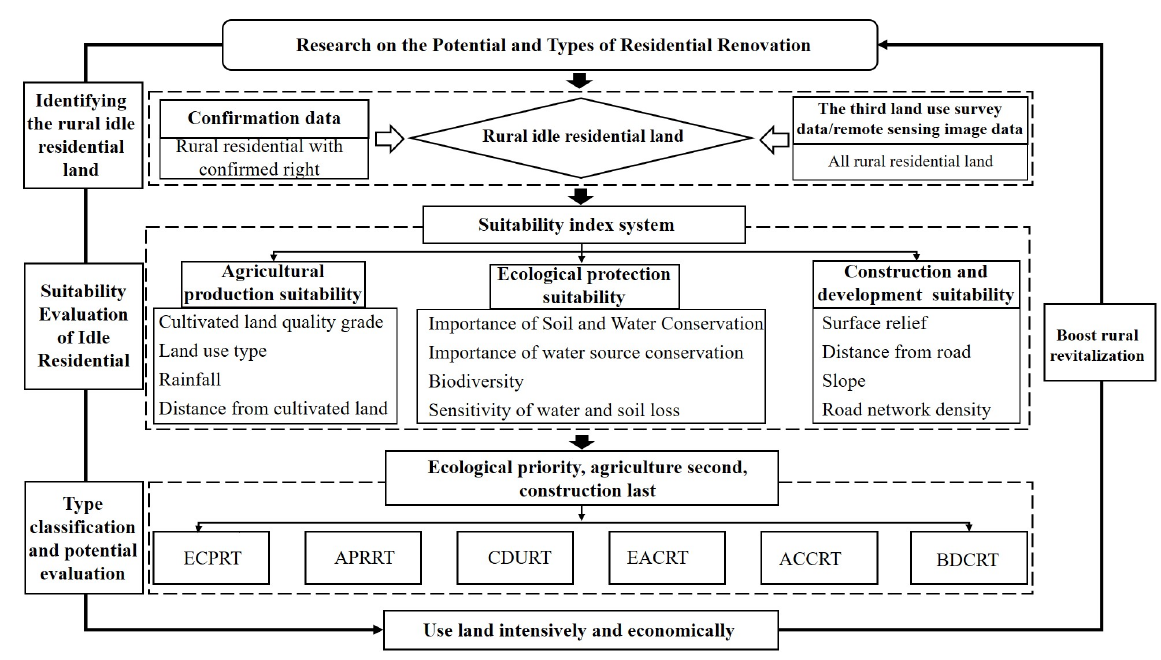
Figure 2. Research framework of residential renovation potential and types.